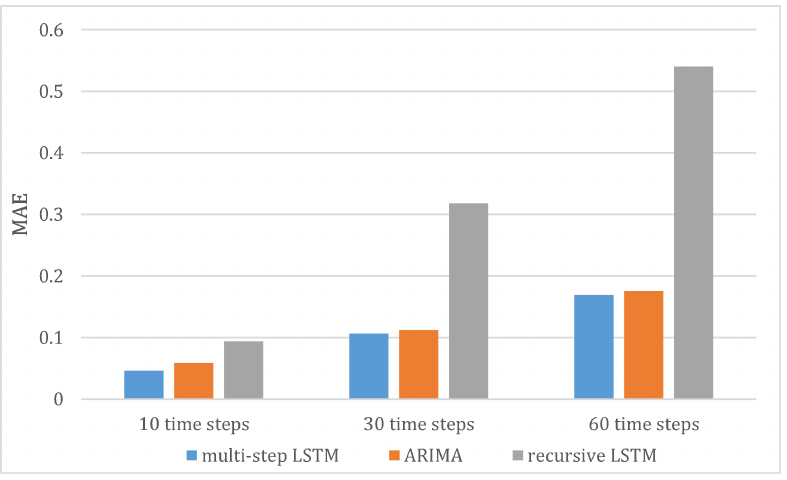
Figure 11. MAE of three models at different output time steps. Table 4. Comparison results of the three models at different output time